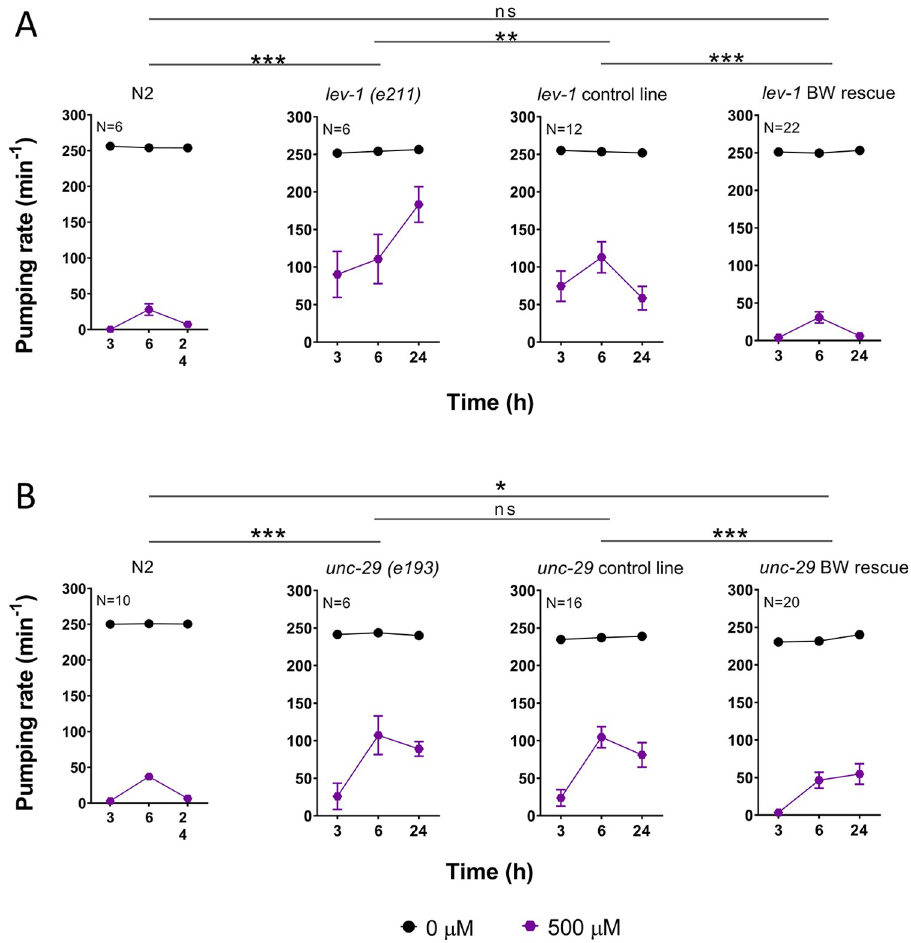
Fig 7. Body wall muscle rescue of the non-alpha subunits LEV-1 and UNC-29 restores wild type sensitivity to prolonged paraoxon-ethyl exposure. A) The pharyngeal sensitivity and the three phases characteristic of drug- induced plasticity to paraoxon-ethyl in the lev-1 deficient worms were restored by introducing the wild type version of the gene selectively in the body wall muscles under control of the myo-3 promoter. Data are shown as mean ± SEM of 6 worms in 3 independent experiments for N2 and lev-1 (e211) strains (N = 6); 12 worms in 6 independent experiments of 2 independent lines for lev-1 control line (N = 12) and 22 worms in 11 independent experiments of 4 independent lines for lev-1 BW rescue (N = 22). The genotype of control and BW rescue lines corresponds to CB211 lev-1 (e211) IV ; Ex[P unc-122 :: gfp ] and CB211 lev-1 (e211) IV ; Ex[P unc-122 :: gfp ; P myo-3 :: lev-1 ], respectively. B) The introduction of the wild type UNC-29 in the body wall muscles of unc-29 mutant worms rescued the consequent inhibition of the pharyngeal function that follows the spontaneous recovery in paraoxon-ethyl exposed worms. Data are shown as mean ± SEM of 10 worms in 5 independent experiments for N2 (N = 10); 6 worms in 3 independent experiments for unc-29 (e193) (N = 6); 16 worms in 8 independent experiments of 3 independent lines for unc-29 control line (N = 16) and 20 worms in 10 independent experiments of 3 independent lines for unc-29 BW rescue (N = 20). The genotype of control and BW rescue lines corresponds to CB193 unc-29 (e193) I ; Ex[P unc-122 :: gfp ] and CB193 unc-29 (e193) I ; Ex [P unc-122 :: gfp ; P myo-3 :: unc-29 ], respectively. Statistical significance was calculated by two-way ANOVA test followed by Bonferroni corrections. ns p > 0.05; * p � 0.05; ** p � 0.01; *** p � 0.001.